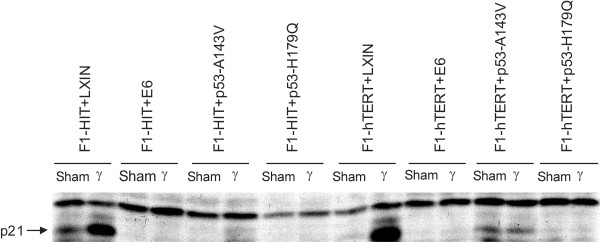
Assessment of p53-dependent induction of p21Waf1 following IR. Western immuno blot to ascertain p21Waf1 induction 6 hr following 1.5 Gy IR was done as described in Methods.